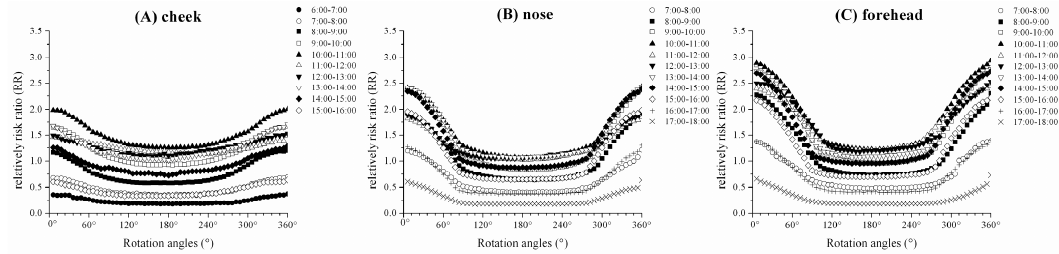
Figure 7. Relative risk ratios (RR) of 1 h cumulative HBE skin relative to the ELs (30 J m − 2 ): ( A ) cheek, ( B ) nose, and ( C ) forehead.